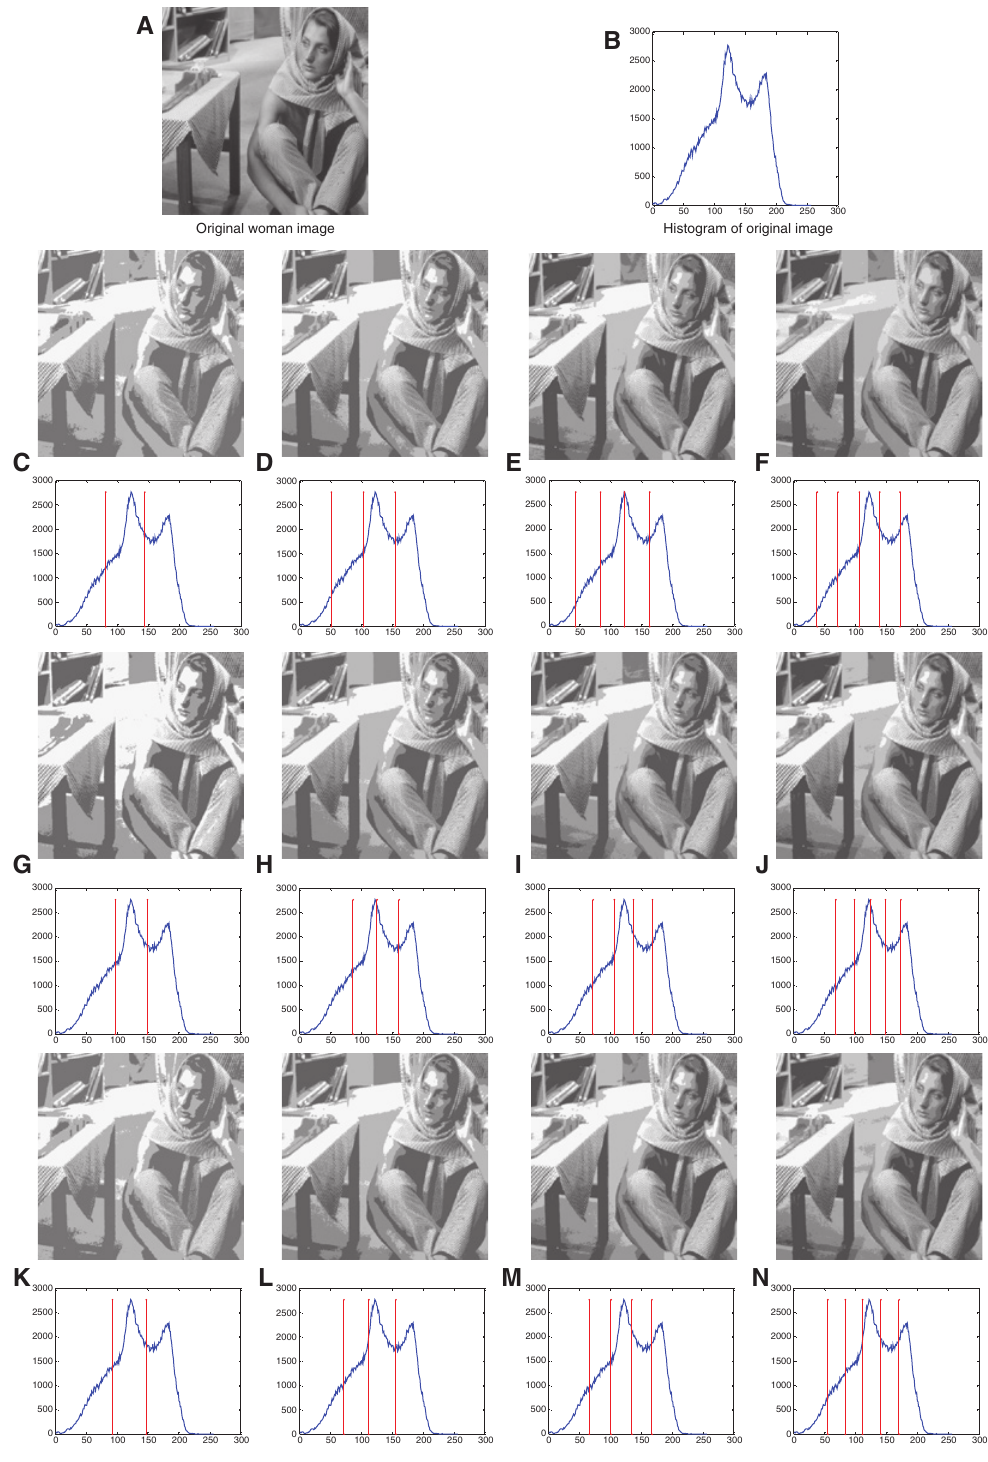
Figure 6: Results of Woman Image Using the HS Algorithm. (A) Original woman image, (B) histogram of original image, (C–F) two-level to five-level thresholding-based segmented image with the best thresholds obtained from the HS algorithm using Kapur’s entropy criterion, (G–J) two-level to five-level corre- sponding histogram labeled with the best threshold values obtained from the HS algorithm based on the between-class vari- ance criterion, (K–N) two-level to five-level thresholding-based segmented image with the best thresholds obtained from the HS algorithm using Tsallis entropy